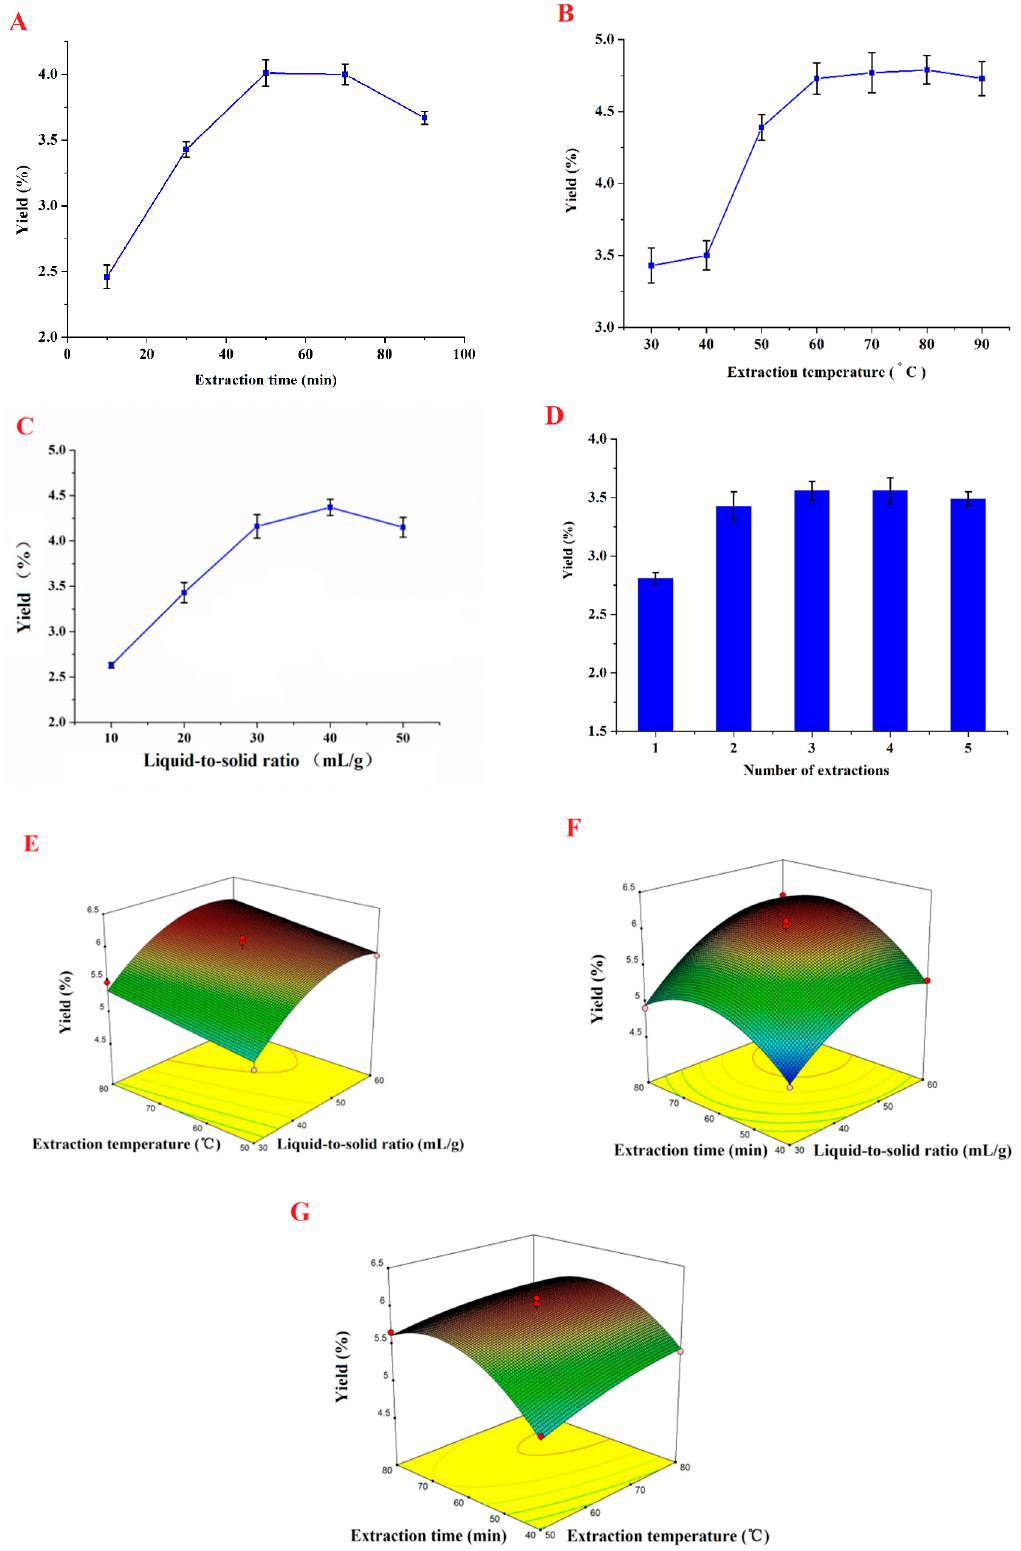
Figure 1. Effects of extraction time ( A ); extraction temperature ( B ); liquid-to-solid ratio; ( C ) and number of extractions ( D ) on the extraction yield of RGP. Each value is presented as mean ± S.D. ( n = 3); Response surface (3D) showing the effects of extraction temperature and liquid-to-solid ratio at a fixed extraction time of 60 min ( E ); extraction time and liquid-to-solid ratio at a fixed extraction temperature 65 °C ( F ); extraction time and extraction temperature at a fixed liquid-to-solid ratio of 45 mL/g on extraction yield of RGP ( G ).